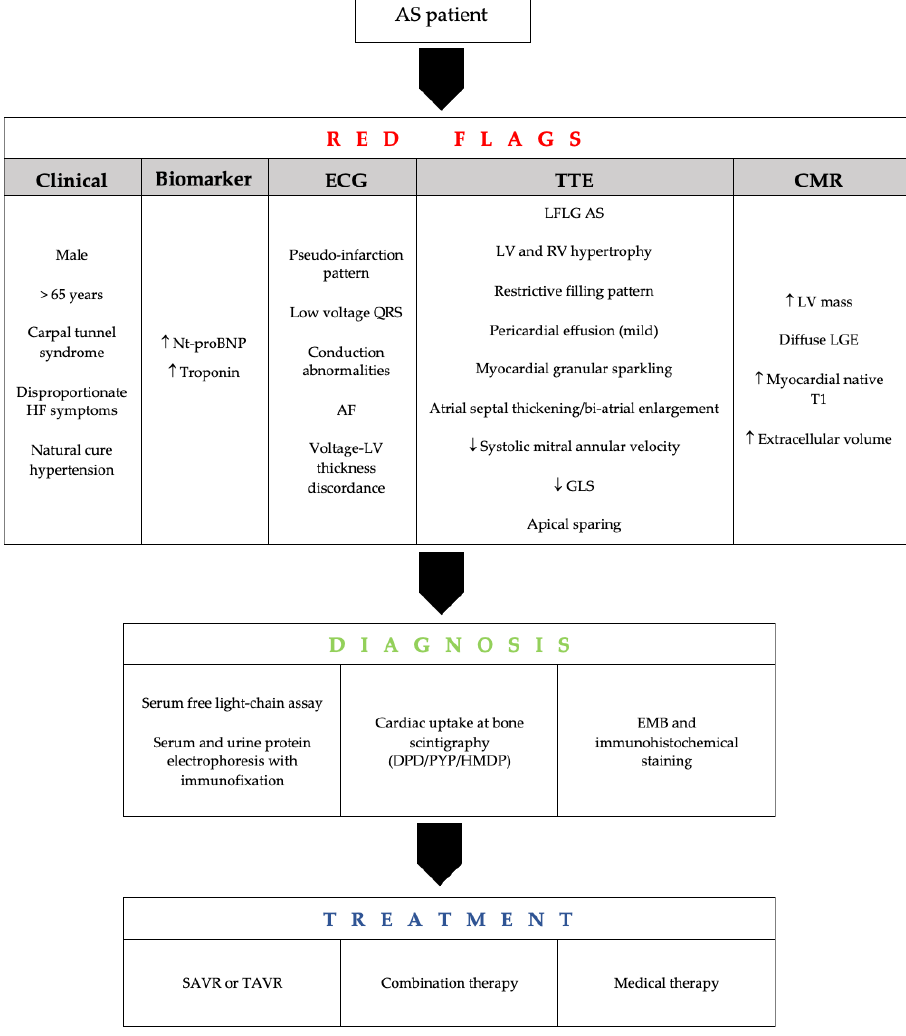
Figure 3. Diagnostic flow-chart and red flags to recognize cardiac amyloidosis involvement in AS patients. See the text for details. Legend—AF: atrial fibrillation; AS: aortic stenosis; DPD: 99mTc-3,3-diphosphono-1,2-propanodicarboxylic-acid; EMB: endomyocardial biopsy; GLS: global longitudinal strain; HF—heart failure; HMDP: 99mTc-hydroxymethylene diphosphonate; LFLG: low-flow low-gradient; LGE: late gadolinium enhancement; LV: left ventricle; Nt-proBNP: N-terminal pro-brain natriuretic peptide; PYP:99mTc-pyrophosphate, SAVR: surgical aortic valve replacement; TAVR: transcatheter aortic valve replacement.